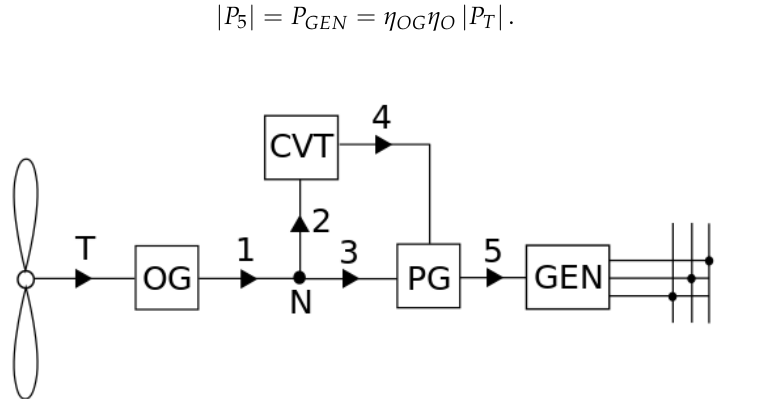
Figure 4. Schematic of the Power Split Hydraulic Transmission System (HTS) with output split configuration. OG is the overgear drive, CVT is the continuously variable transmission (the HTS in this case), PG is the Planetary Gearbox, and GEN is the electric